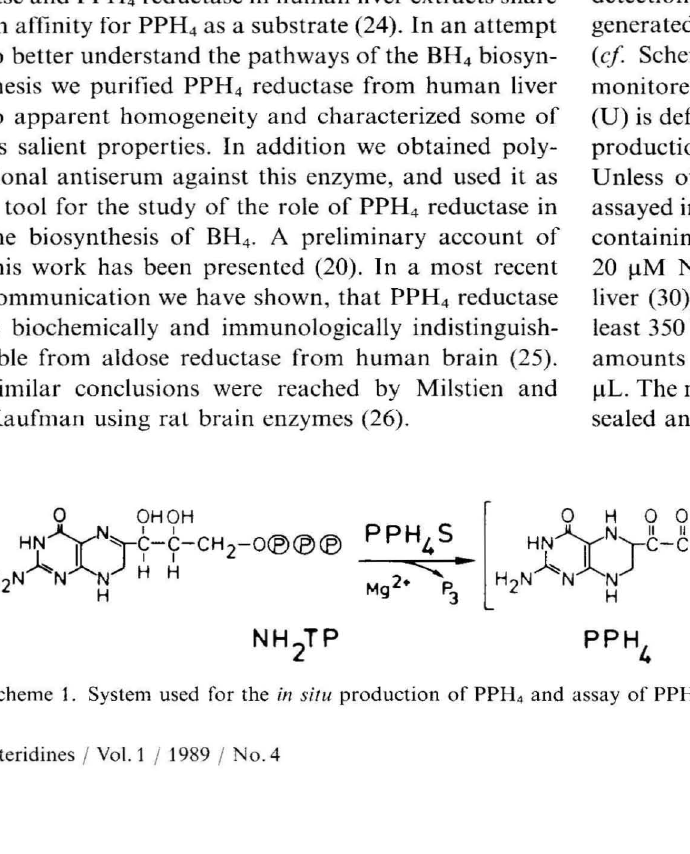
Scheme 1. System used for the in Silu production of PPH Pteridines / Vol. 1 / 1989 I